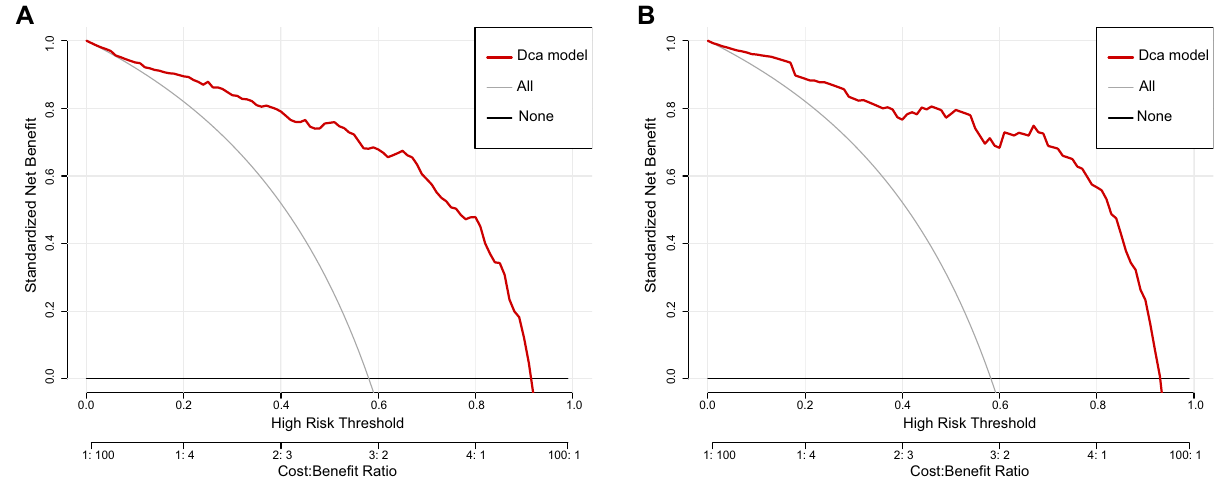
Figure 5. Decision curve for the nomogram predicting MN in (A) training group or (B) test group. Net benefit is shown on the y-axis. The thick red line represents the model; the thin gray line represents the assumption that all patients have MN; the thin black line represents the assumption that all patients have MCD. In training group, the decision curve showed that if the threshold probability of a patient is between 0.02 and 0.91, using the nomogram in the present study to predict MN adds more benefit than performing biopsy on all or no patients.